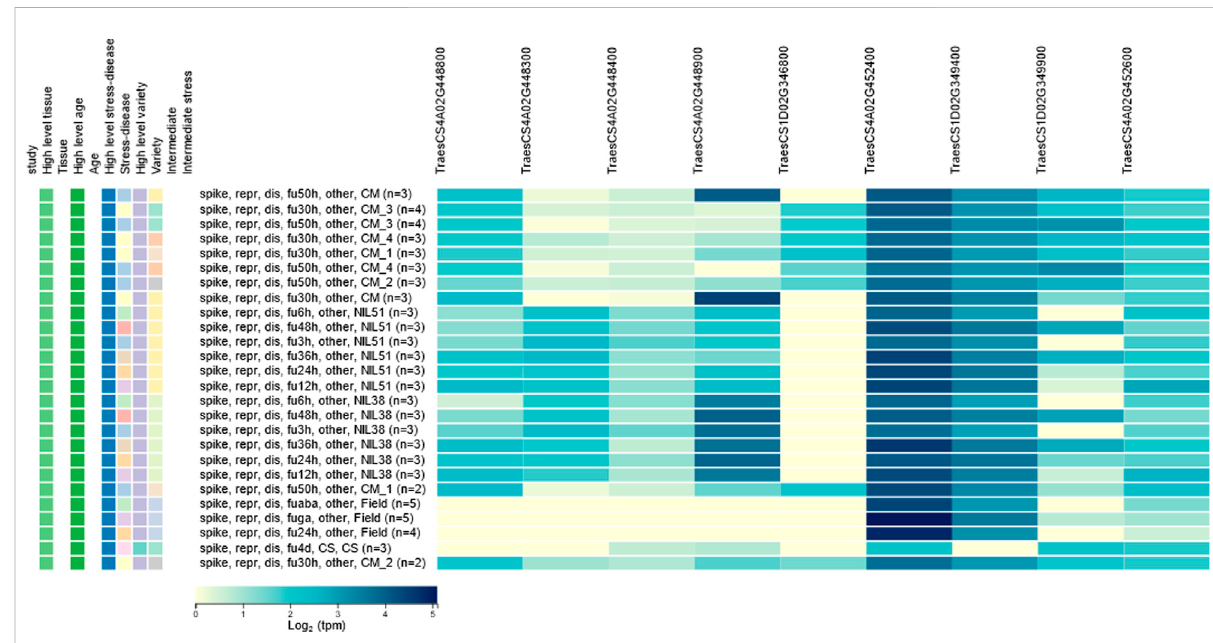
FIGURE 6 In silico expression analysis for candidate genes. Nine genes were reported expression against fusarium several hours after inoculation.